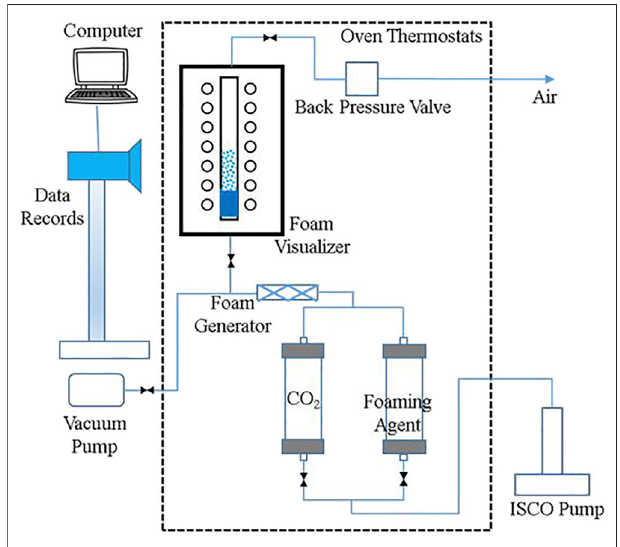
FIGURE 1 | Schematic illustration of the apparatus used for foam